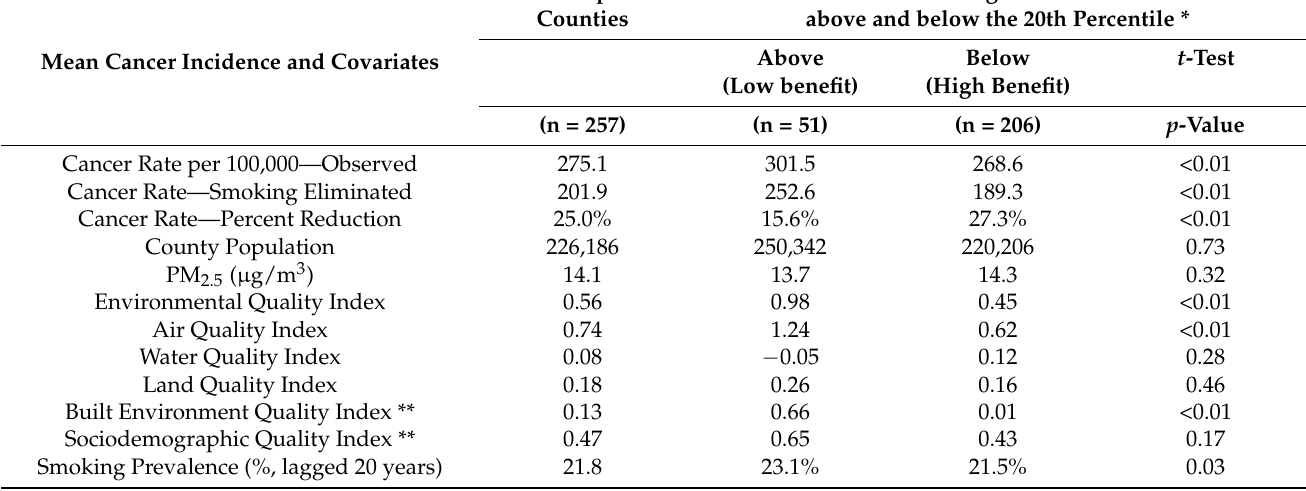
Table 2. Incidence rates of 12 smoking-related types of cancer in the 257 SEER metropolitan counties, 2016, as observed and assuming smoking elimination, and